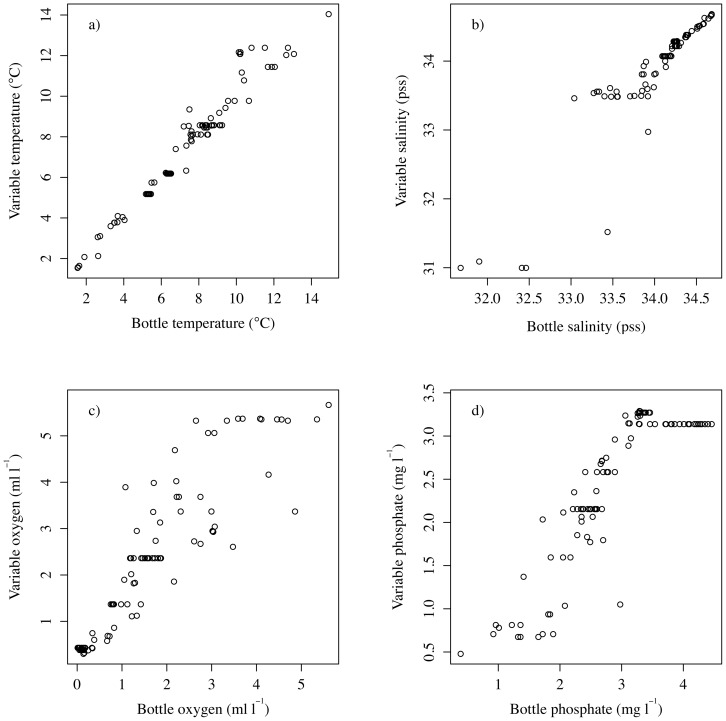
Validation of the environmental layer creation process by comparing the variable value on y axis (Variable), against WOD 2009 CTD data (Bottle, on × axis).a) Temperature, b) salinity, c) dissolved oxygen and d) phosphate.